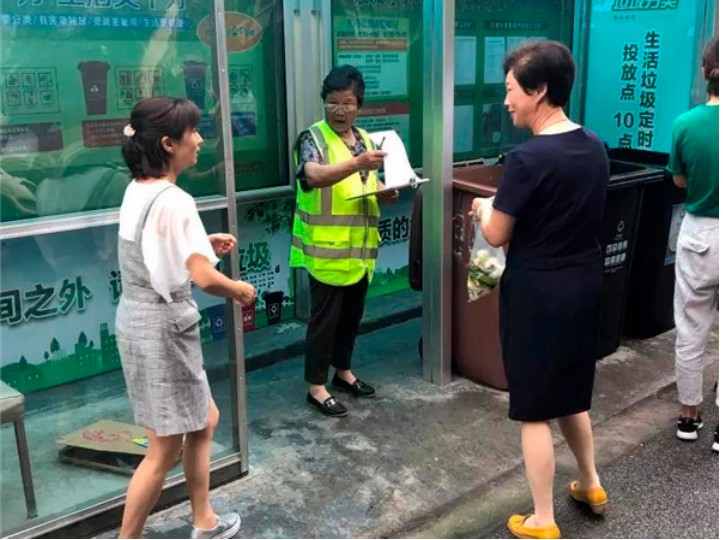
Figure 5. A volunteer working at a waste collection point [28].